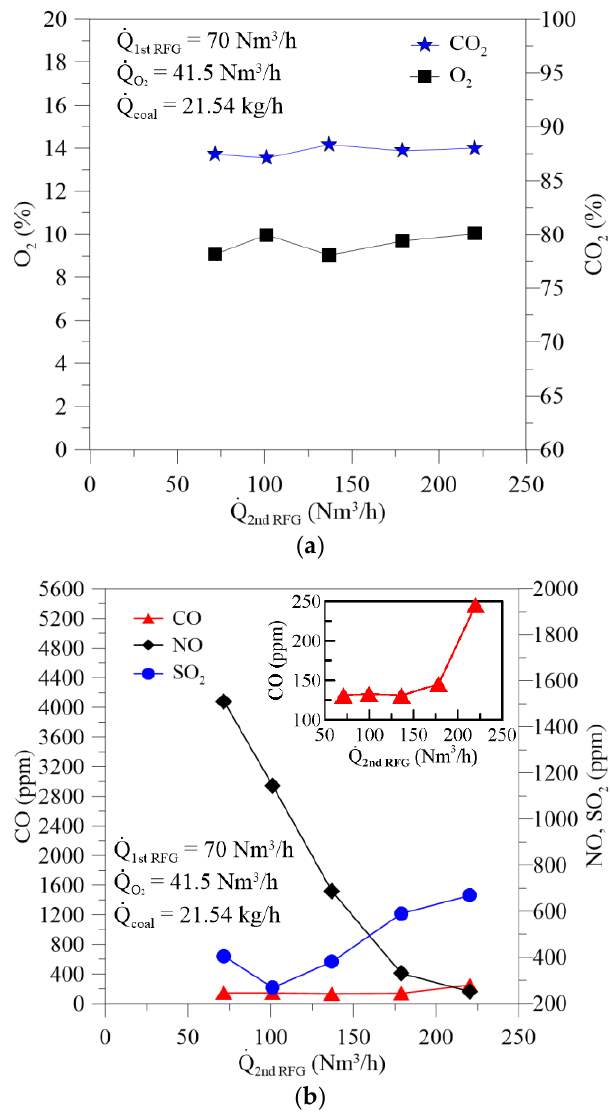
Figure 7. ( a ) CO 2 and O 2 emissions; and ( b ) CO, NO, and SO 2 emissions for Australian coal during oxy-combustion at